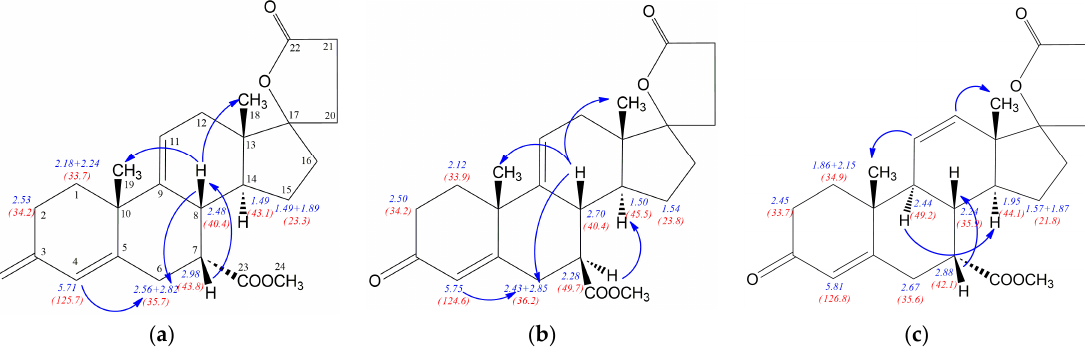
Figure 4. Crucial 1 H- and 13 C-NMR chemical shifts and NOE effects for esters: ( a ) (7 α ,17 α )-9(11)-ene 7 ; ( b ) (7 β ,17 α )-9(11)-ene 7a ; ( c ) (7 α ,17 α )-11-ene 7b .